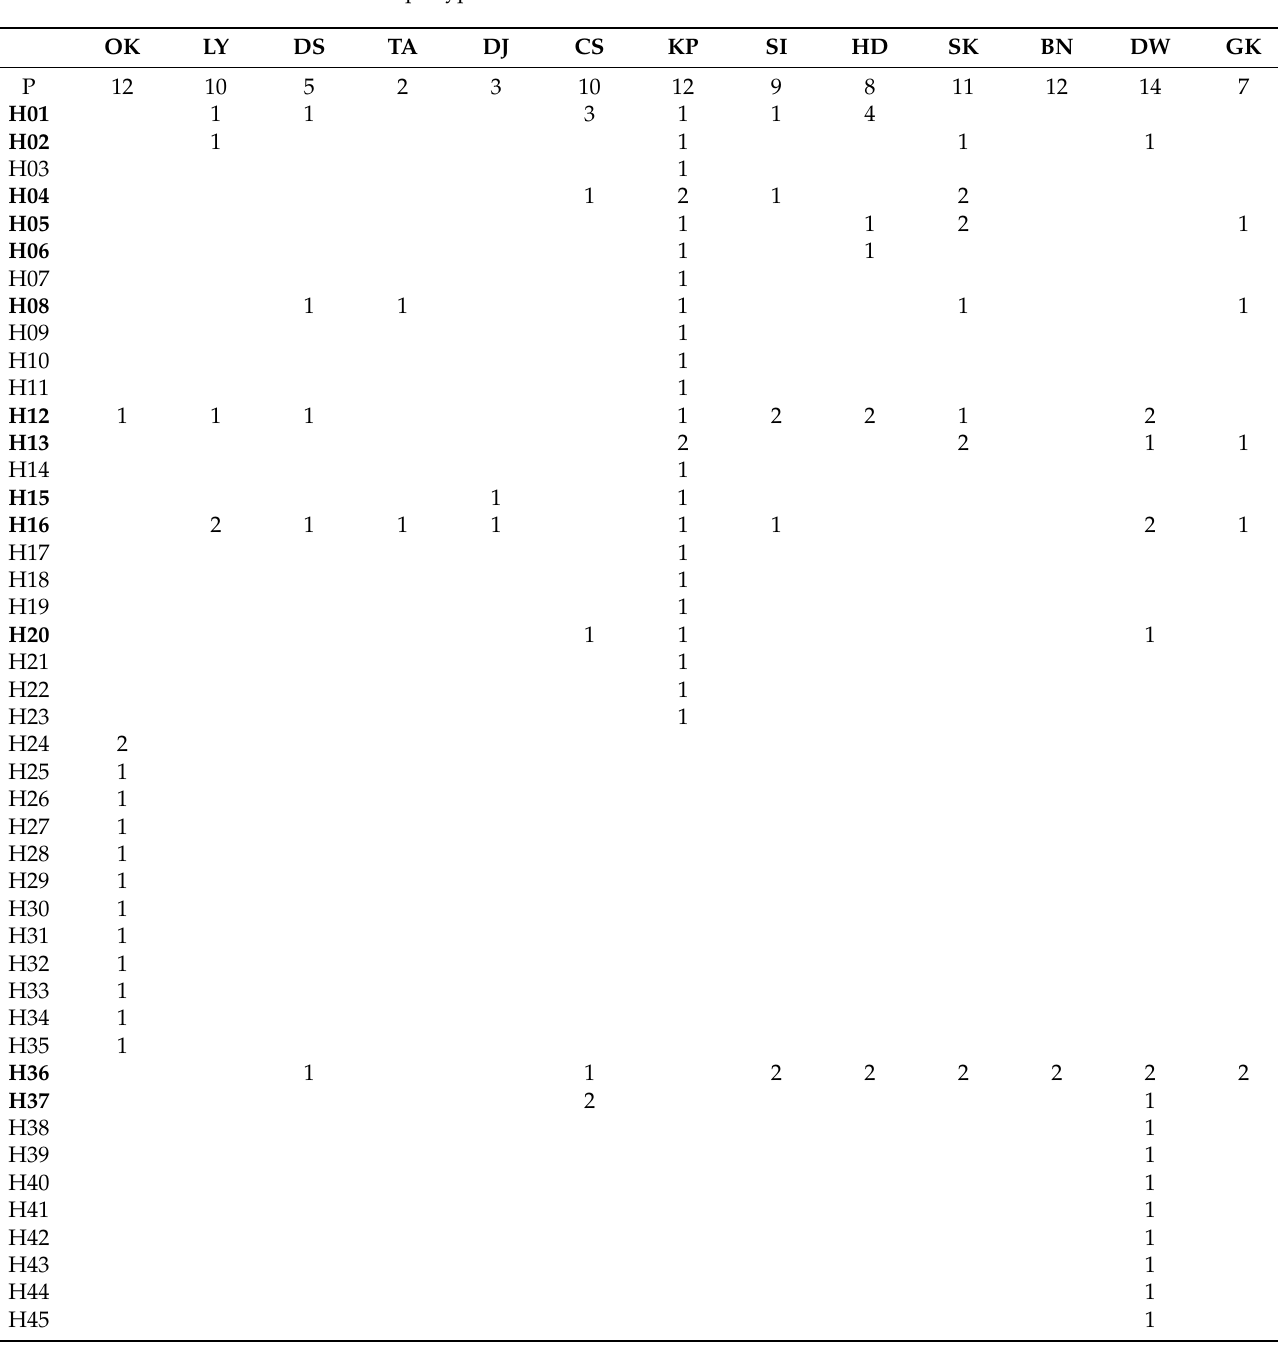
Table A1. The distribution information of the shared haplotypes (H01–H142). P indicates the number of private haplotypes in each population. The haplotype numbers in boldface type indicate shared